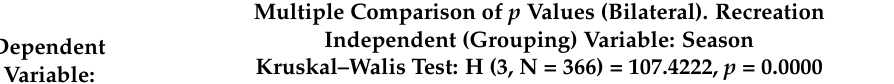
Table 4. Multiple comparisons of mean ranks of recreation activities for all pairs of groups (Season). p Values are two-sided significance levels with a Bonferroni